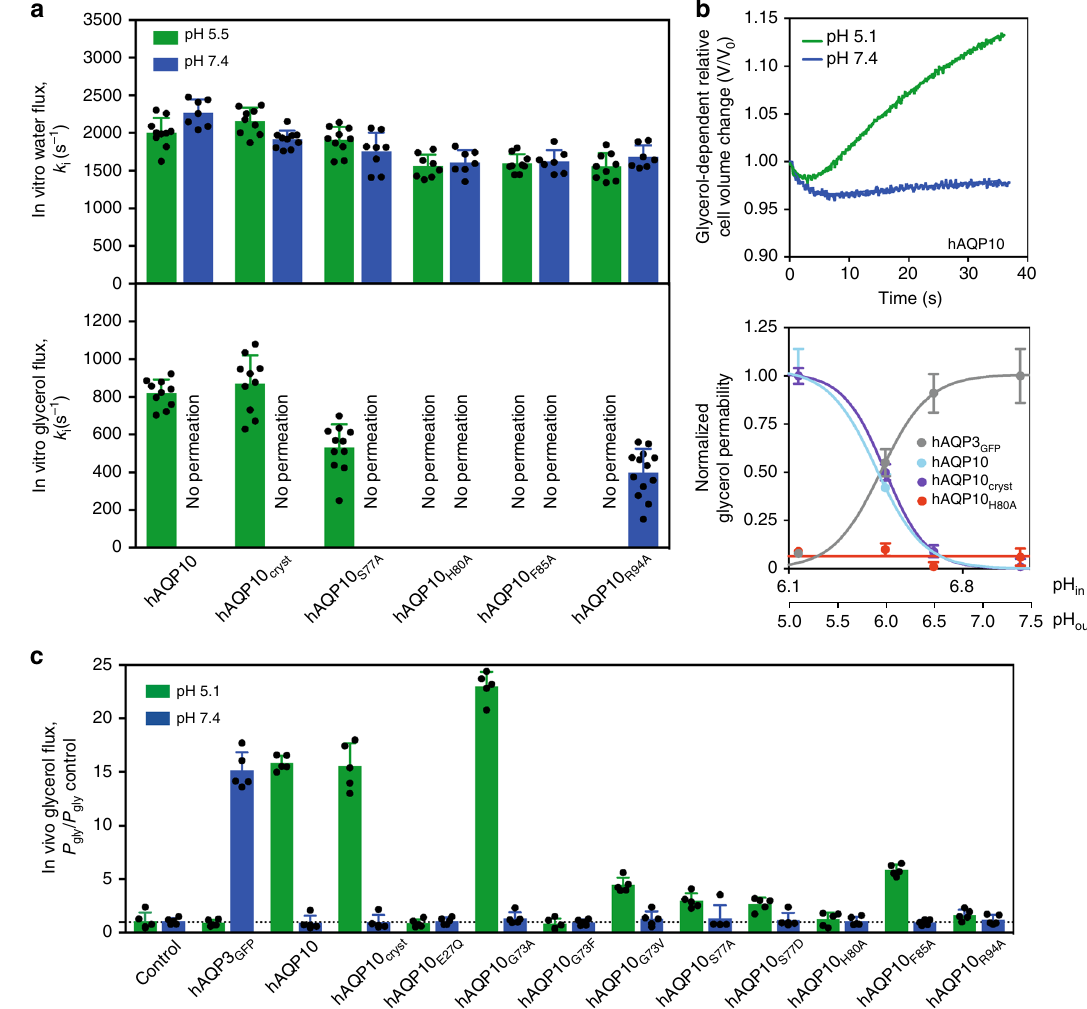
Fig. 3 Functional characterization of human AQP10. a Water and glycerol permeability of hAQP10 forms reconstituted into polymersomes. k i rate constants (s − 1 ) were obtained at pH 7.4 (blue) and pH 5.5 (green). Each bar shows mean ± SD of N = 7 – 13 measurements performed for the same proteopolymersome sample. Data for shrinking proteopolymersomes indicate lack of glycerol fl ux and are not shown. See Supplementary Table 2 for a summary of the activity. b Upper plot: Representative time course of the relative cell volume (V/V 0 ) changes after glycerol osmotic shock at pH 5.1 (green) and 7.4 (blue) in hAQP10 expressing yeast cells. Lower plot: pH-dependence of glycerol permeability (P gly ) measured in cells expressing hAQP3 GFP (gray) or different hAQP10 forms (cyan, blue and red). P gly is normalized for each dataset ((P gly -P gly control )/P gly max ) and fi tted with a Hill equation. Corresponding internal pH (pH in ) is also shown (lower axis). Results are given as mean ± SD of at least N = 3 independent experiments. c Glycerol permeability (P gly ) ratio of yeast cells expressing hAQP3 GFP or hAQP10 forms measured at pH 5.1 (green) and pH 7.4 (blue). Results are normalized to P gly of the control strain at the respective pH. Data for hAQP10 F85V are not shown due to the uncertainty of precise P gly estimation at pH 5.1 (P gly /P gly control > 30). See Supplementary Fig. 6e for the equivalent water fl ux data. Results are given as mean ± SD of N = 5 independent plasmids were assembled directly in the S. cerevisiae production strain PAP1500 (originating from Pedersen laboratory) by homologous recombination of HindIII-,